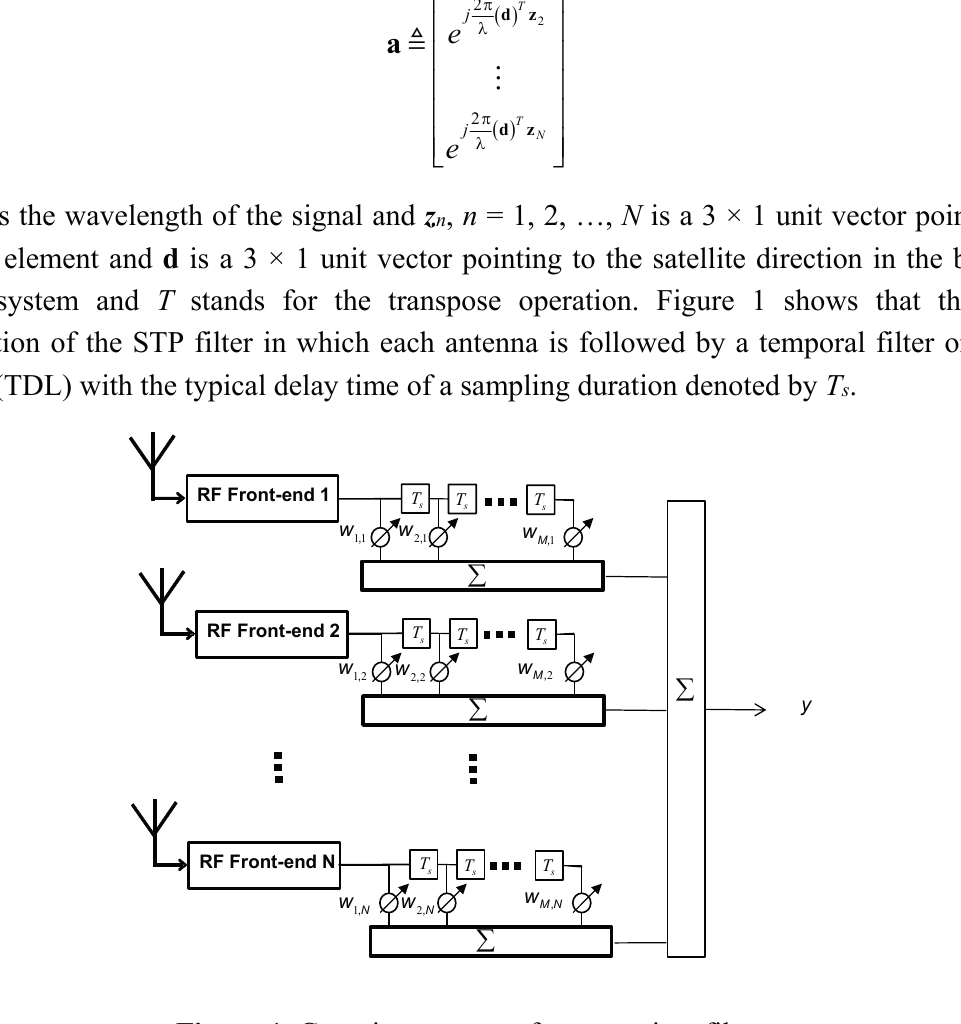
Figure 1. Generic structure of a space-time